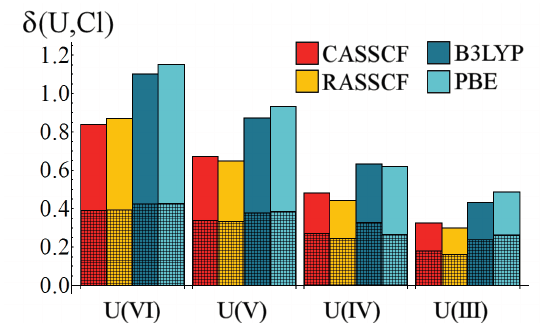
Figure 5. QTAIM calculated atomic basin of uranium in UCl 6 , illustrating the O h symmetry of the basin.